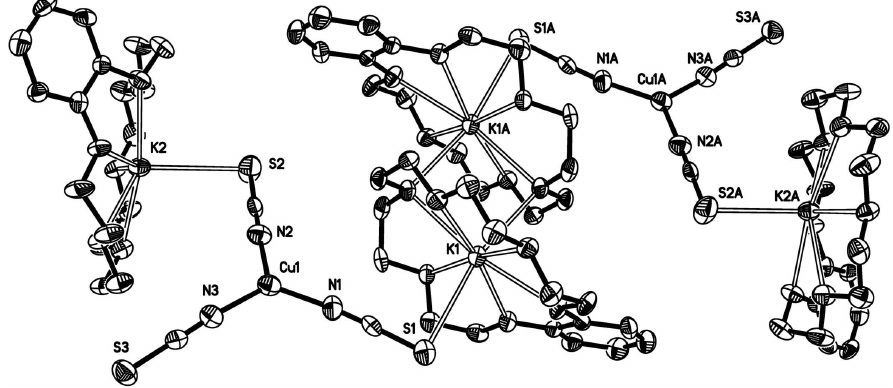
The title complex (H atoms omitted) showing the numbering scheme for Cu, K, N and S atoms. Displacement ellipsoids are drawn at the 30% probability level. Atoms with the suffix A are generated by the symmetry operator 1 - x , - y , 1 - z